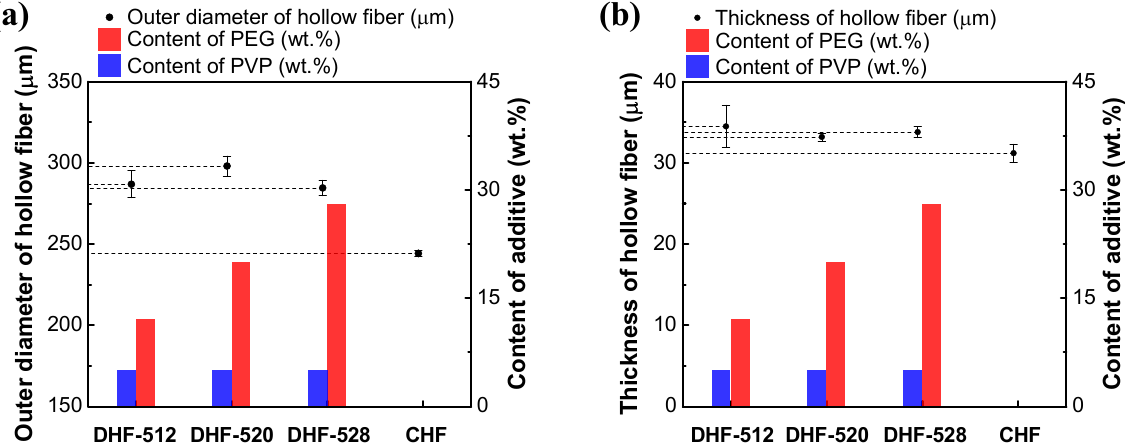
Figure 4. Comparison of membrane structure based on PEG contents: ( a ) OD of DHFs and CHF, ( b ) membrane thickness of DHFs and CHF. The membrane ID could be deduced from the difference between OD and thickness.